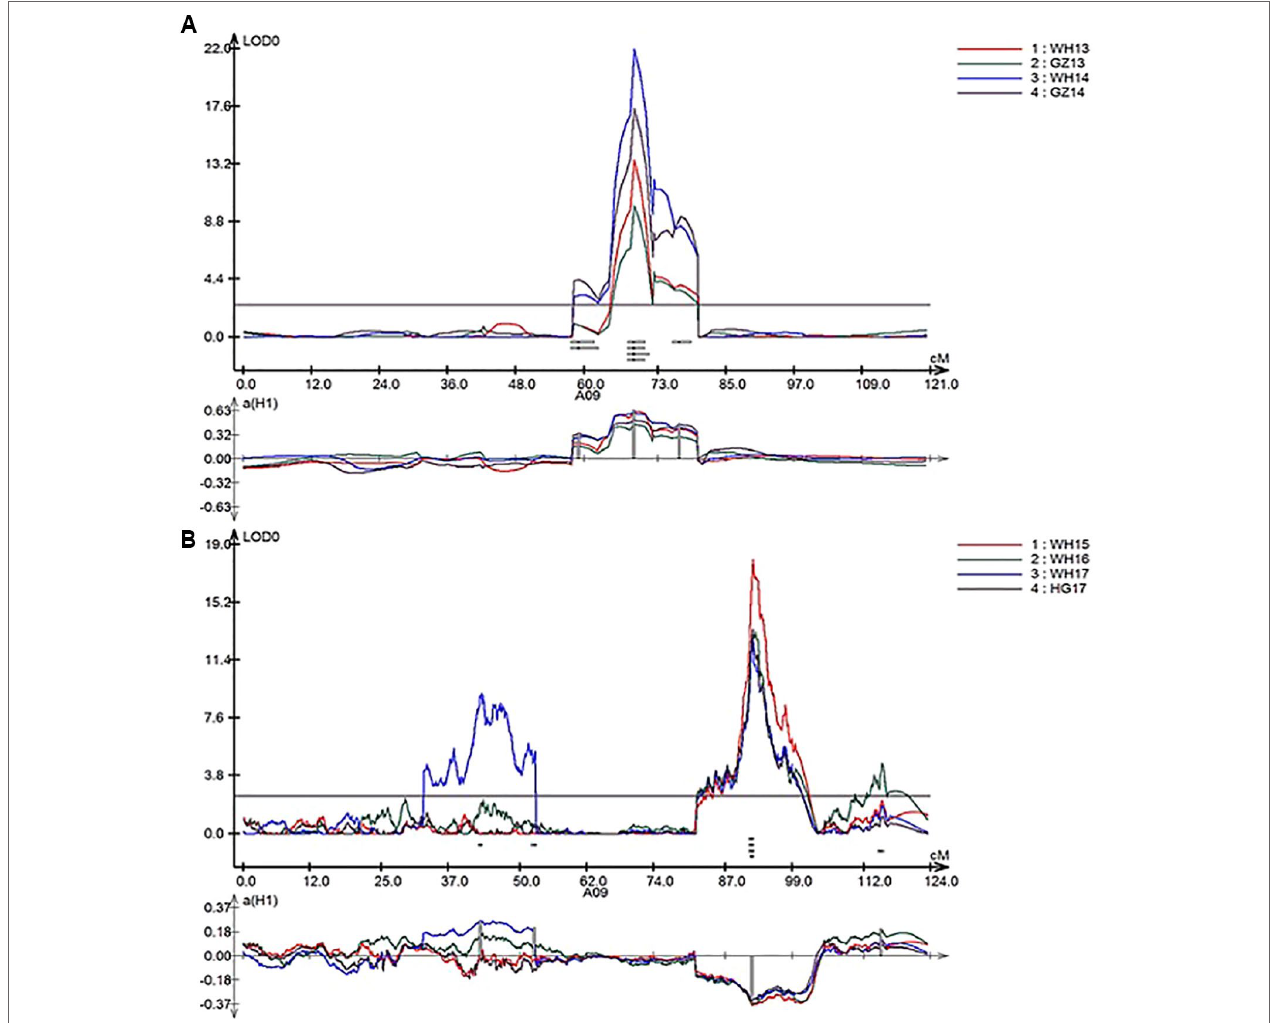
FIGURe 4 | LOD profiles of RR (a) and ZR (B) populations for silique length (SL) as a major quantitative trait locus (QTL) in linkage group A09 from four environments.